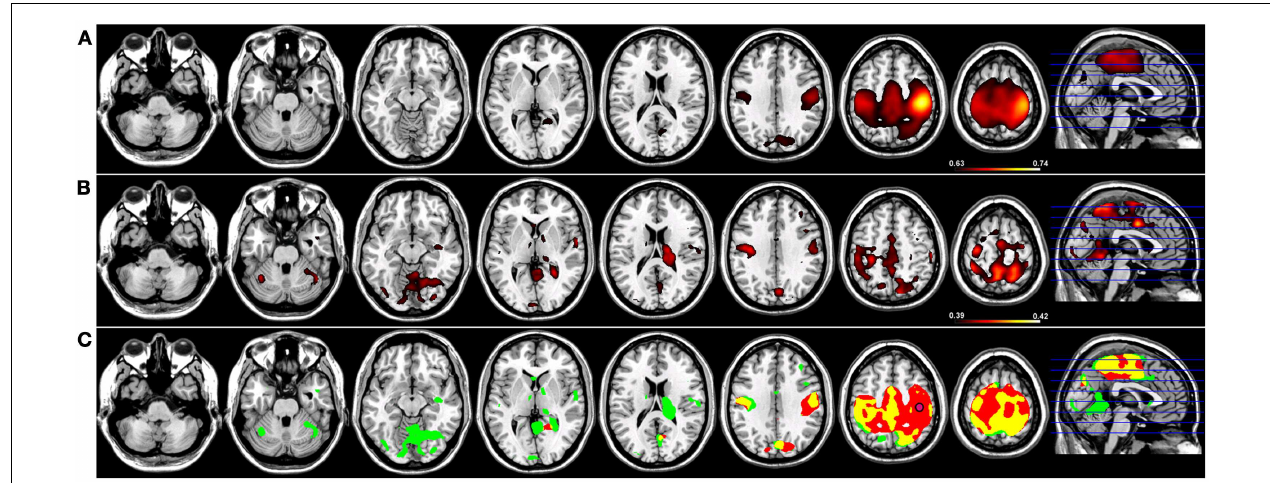
FIGURE 3 | Resting-state functional connectivity maps for a seed placed in right primary motor cortex (M1; pink circle) in 15 healthy control subjects reconstructing the sensorimotor network (SMN) for right M1 . (A) SMN reconstruction using magnitude coherence (Coh).